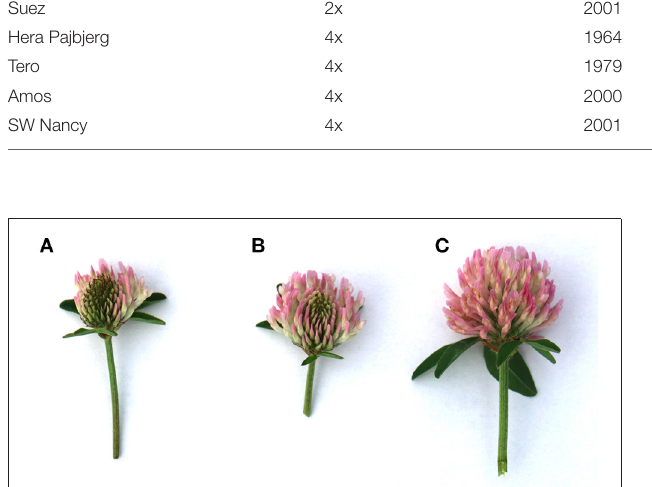
FIGURE 1 | Different flowering stages of red clover flower heads: (A) early flowering—when the first 20 florets per flower head were open; (B) middle flowering—when nearly half of the florets per flower head were open; and (C) full flowering—when all of the florets per flower head were open.